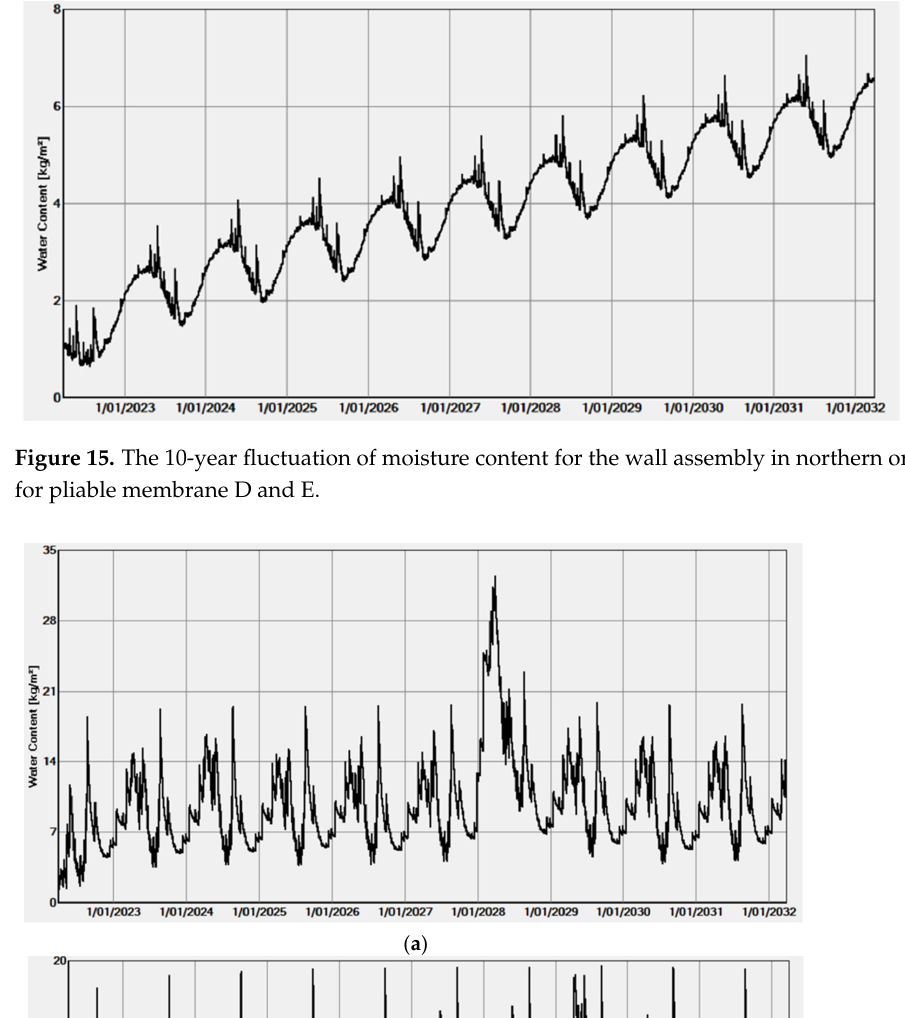
orientation for pliable membrane B (single and multipoint).